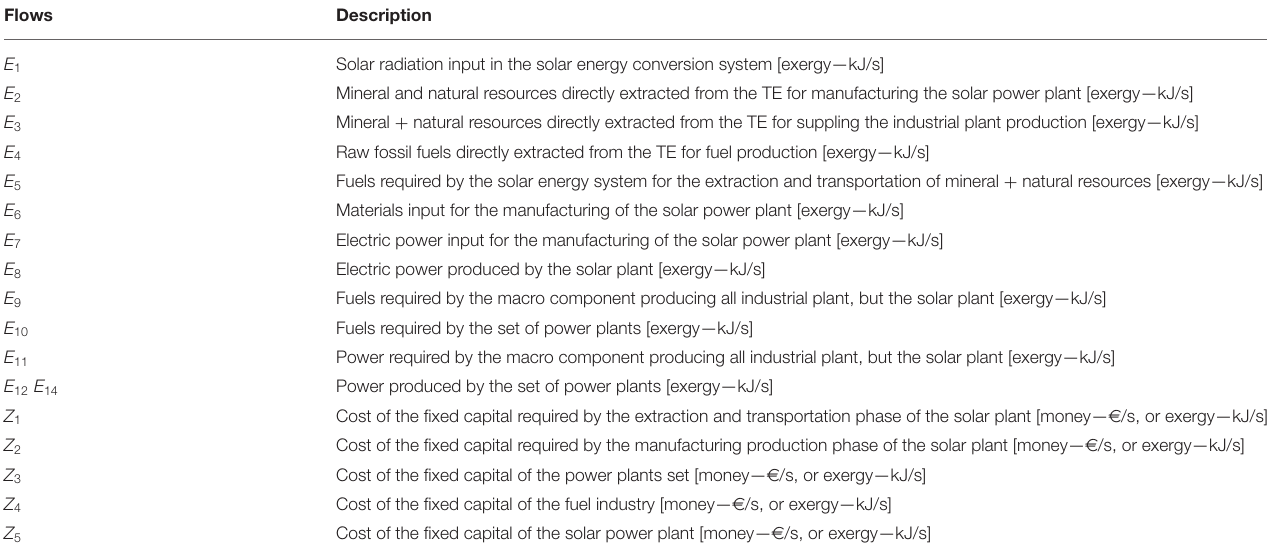
TABLE 1 | Description of the flows in the extended energy production system in Figure 2 . Flows